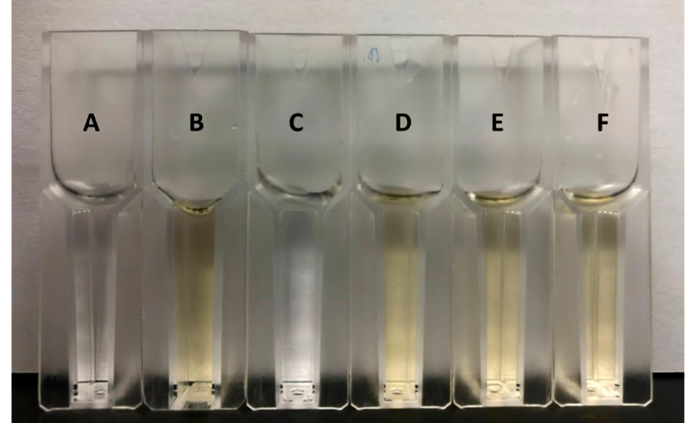
Figure 3. The proteolytic assay mixture of the N-CBZ-Gly- p NP substrate. Tube A is a blank (only substrate, without MD2-SBro and free GST protein). Tubes B and C are the mixture containing the substrate with MD2-Sbro and substrate with free GST protein, respectively. Tubes D, E, and F refer to the mixtures containing substrate, MD2-SBro, and free GST protein. The ratio of MD2-SBro and free GST protein were 1:1 (reaction D), 1:10 (reaction E), and 1:50 (reaction F).